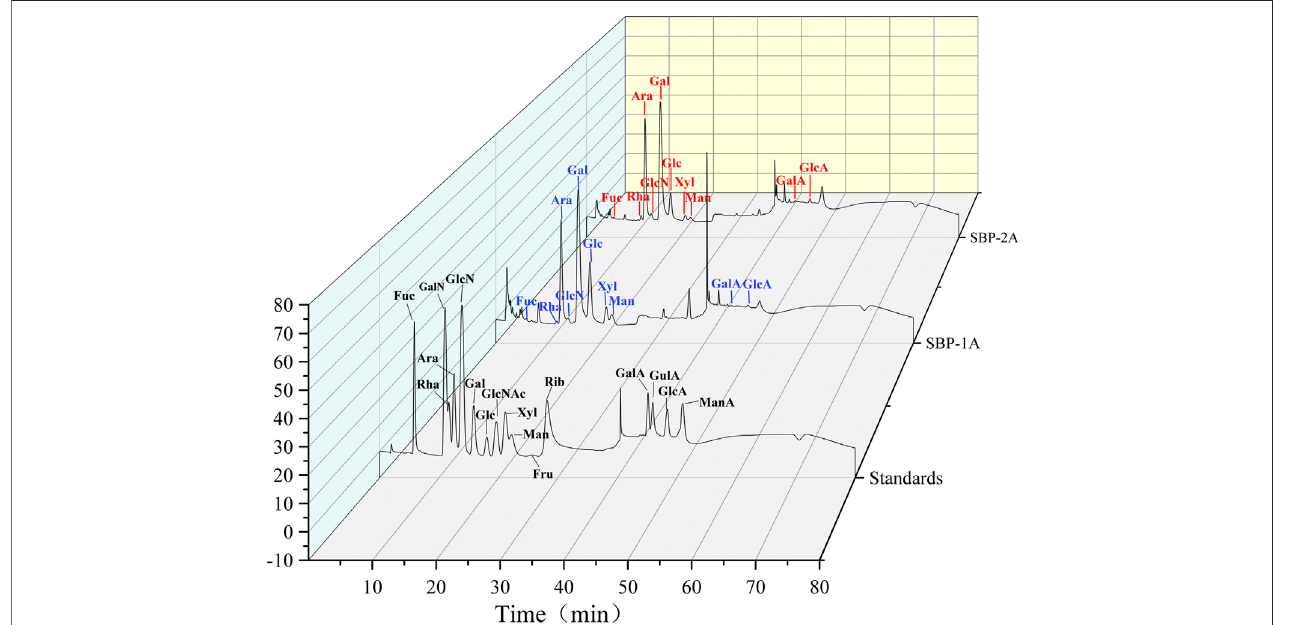
FIGURE 4 | IC chromatogram of mixed monosaccharide standards SBP-1A and